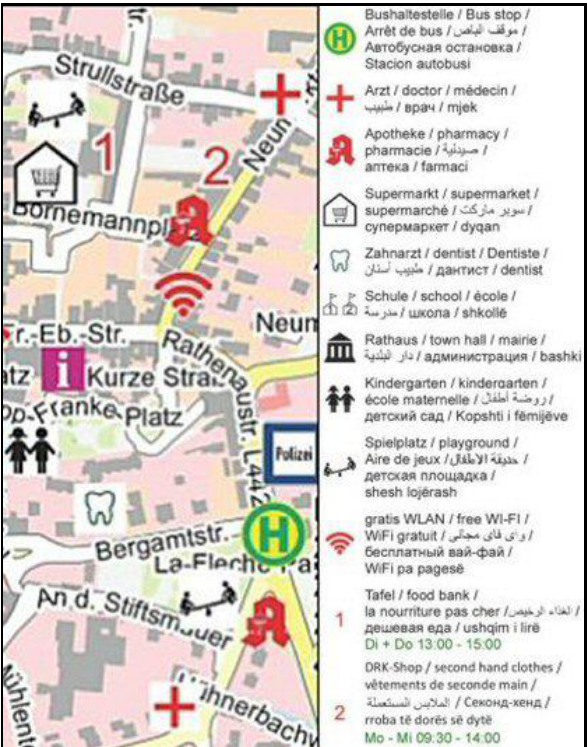
Figure 5: Special City Map for Refugees of the City of Obernkirchen with a legend in six languages (Stübke